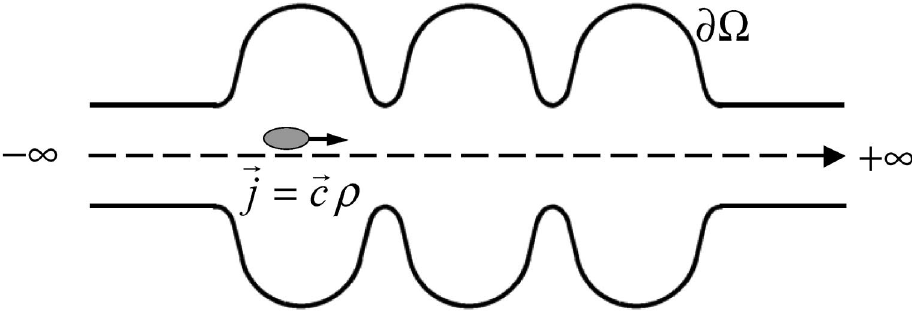
FIG. 1. Charged particle bunch moving through an accelerating structure supplied with infinite